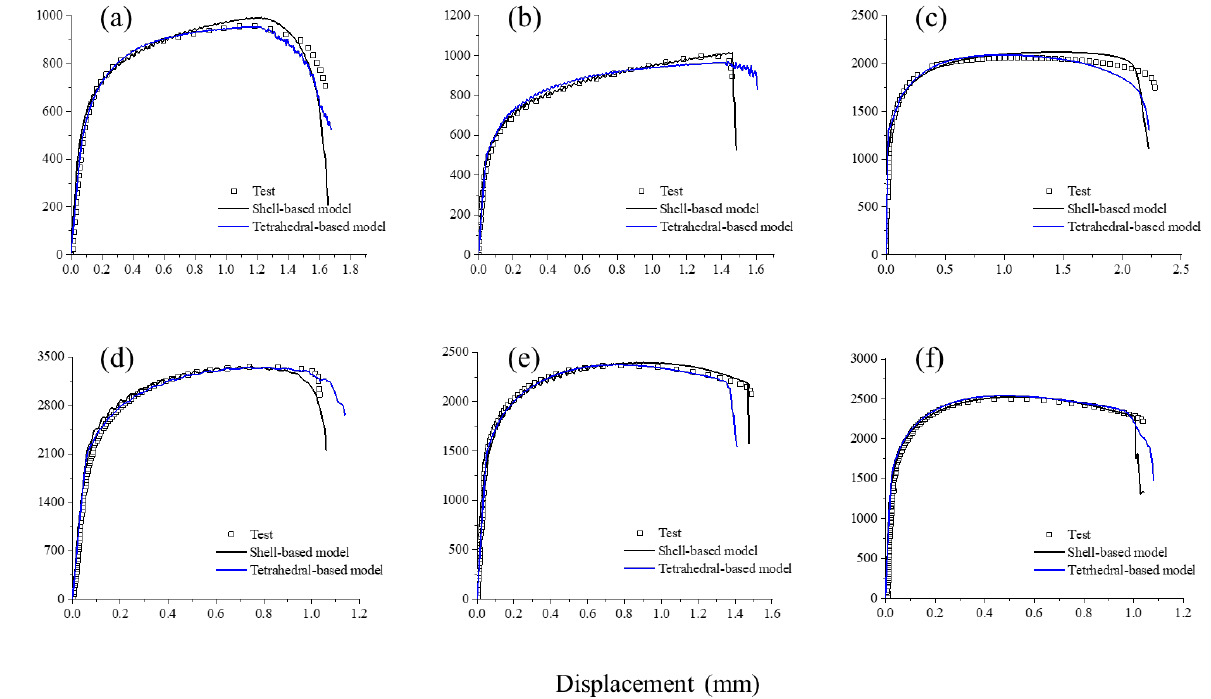
Figure 10. Shell-based model simulation vs. experiments for MAT 1 using GISSMO: ( a ) shear specimen, ( b ) tensile–shear specimen, ( c ) tensile specimen, ( d ) center hole specimen, ( e ) R20 notched specimen, and ( f ) R5 notched specimen.